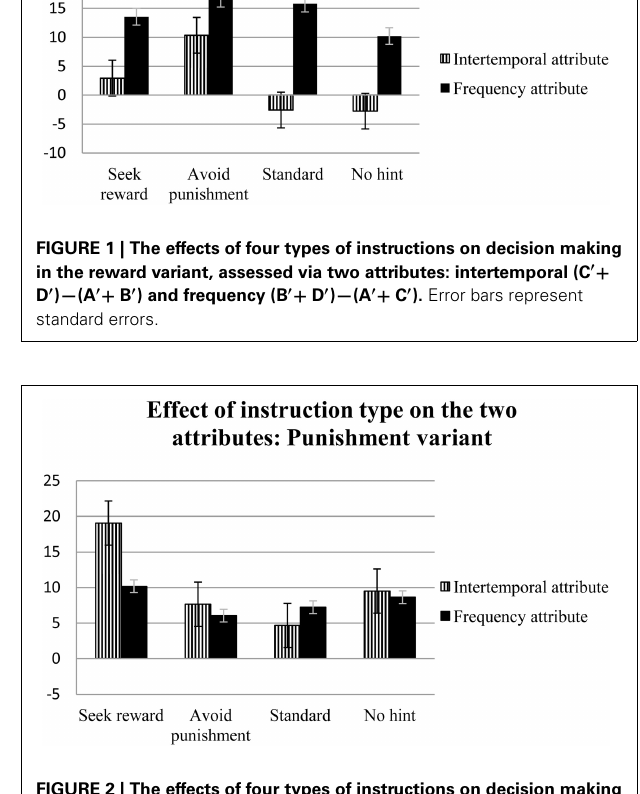
FIGURE 2 | The effects of four types of instructions on decision making in the punishment variant, assessed via two attributes: intertemporal (E (cid:2) + G (cid:2) )—(F (cid:2) + H (cid:2) ) and frequency (F (cid:2) + G (cid:2) )—(E (cid:2) + H (cid:2) ). Error bars represent standard